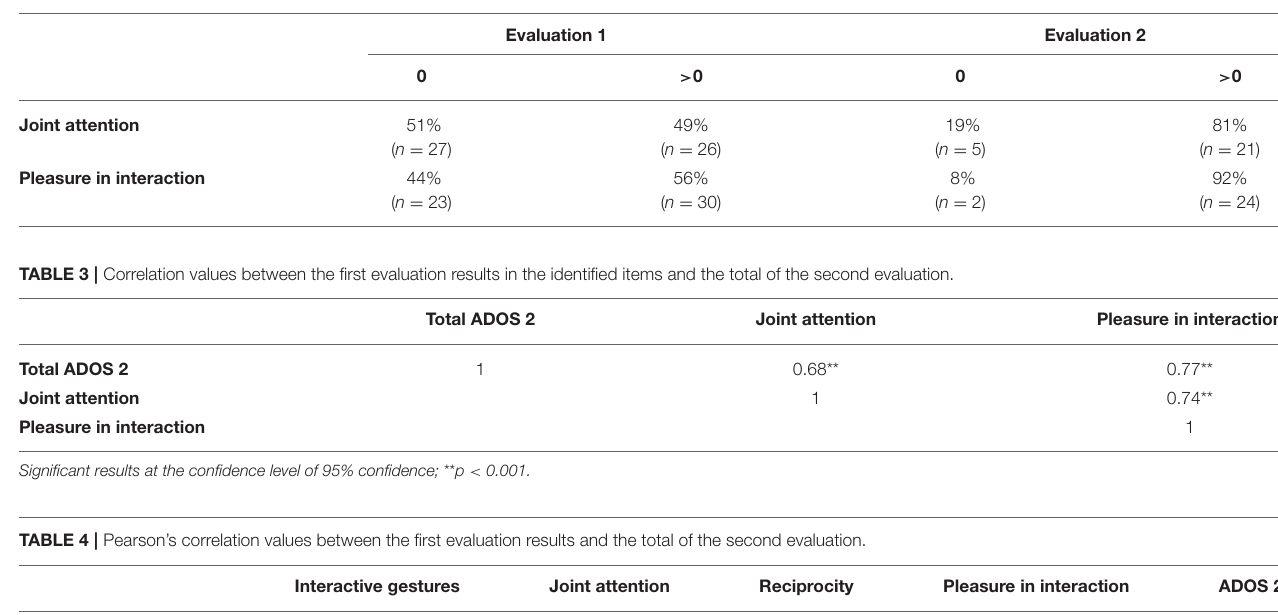
TABLE 2 | Score frequency per item in children with ADOS total > 8.